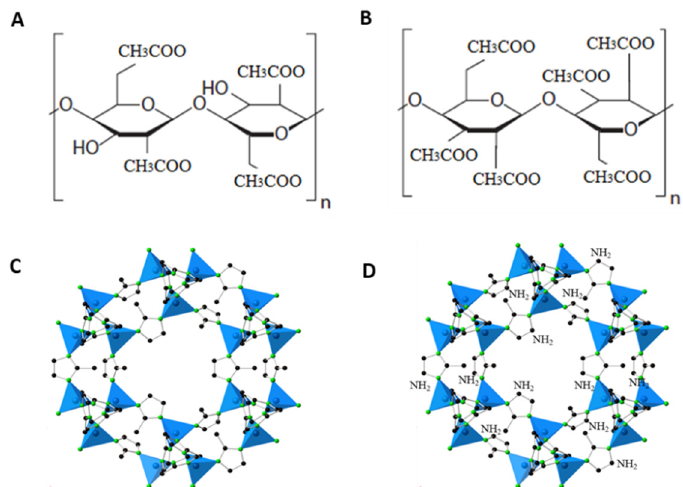
Figure 1. Chemical structure of ( A ) cellulose diacetate (CDA), ( B ) cellulose triacetate (CTA), ( C ) ZIF-8, and ( D ) NH 2 -ZIF-8, Reprinted with permission from ref. [37]. Copyright 2013 Springer